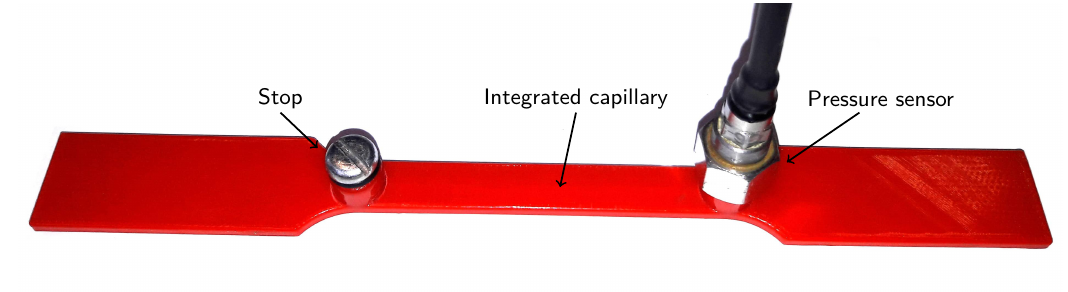
Figure 6. The presented load monitoring system for 3D printed